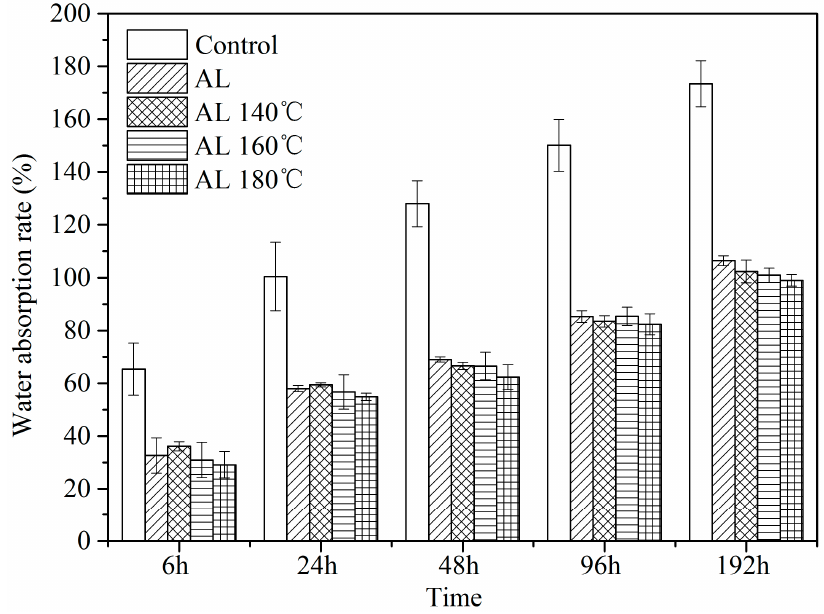
Figure 8. Water absorption rate of the samples as a function of immersion time.